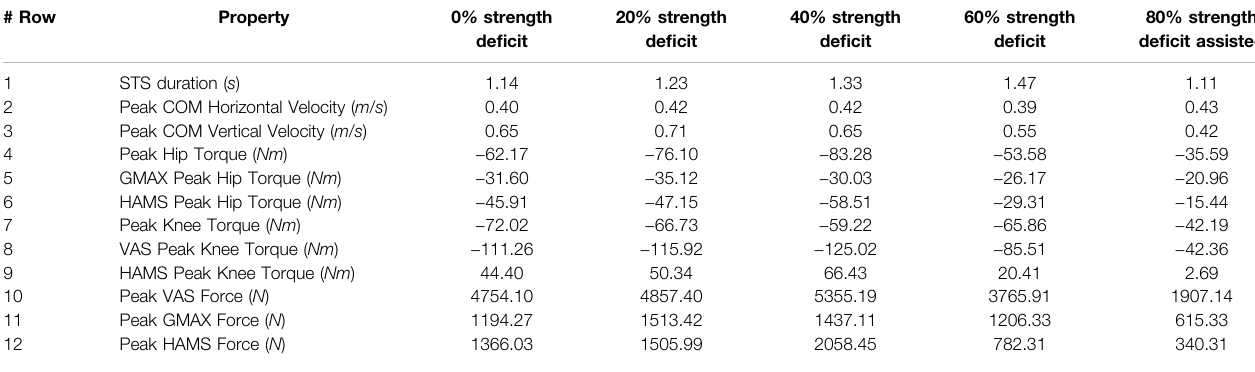
TABLE4| Propertiesofthe0,20,40,60%andexternallyassisted80%strengthde fi citmodel ’ sSTStrajectories.Rows fi ve,six,eightandnineshowcontributionsofmuscles to peak resultant joint